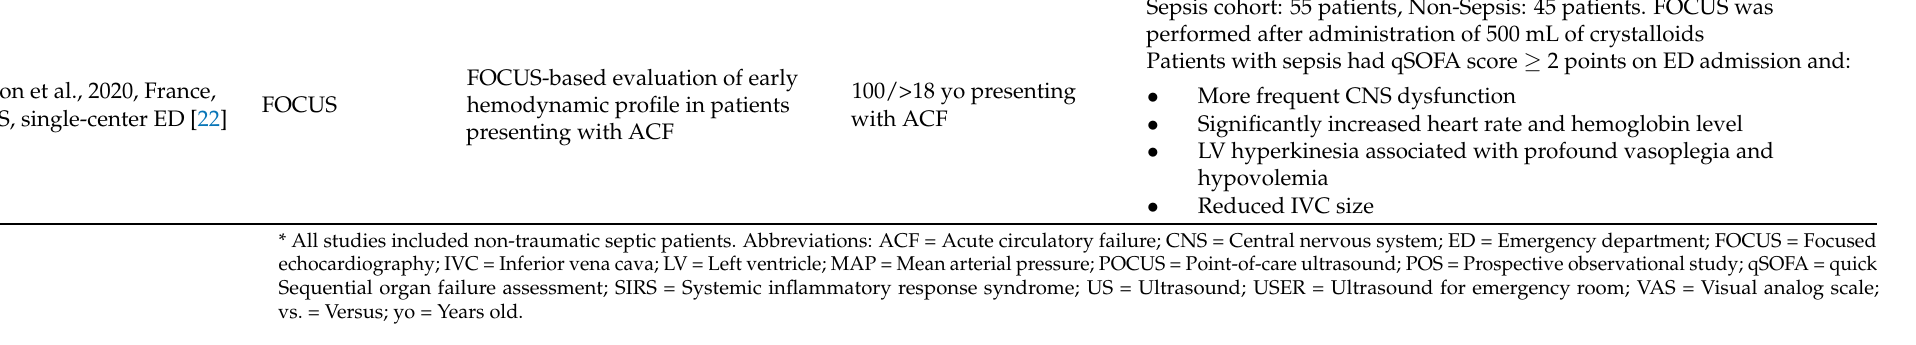
Table 3. Case reports depicting POCUS contribution to the diagnosis and management of septic